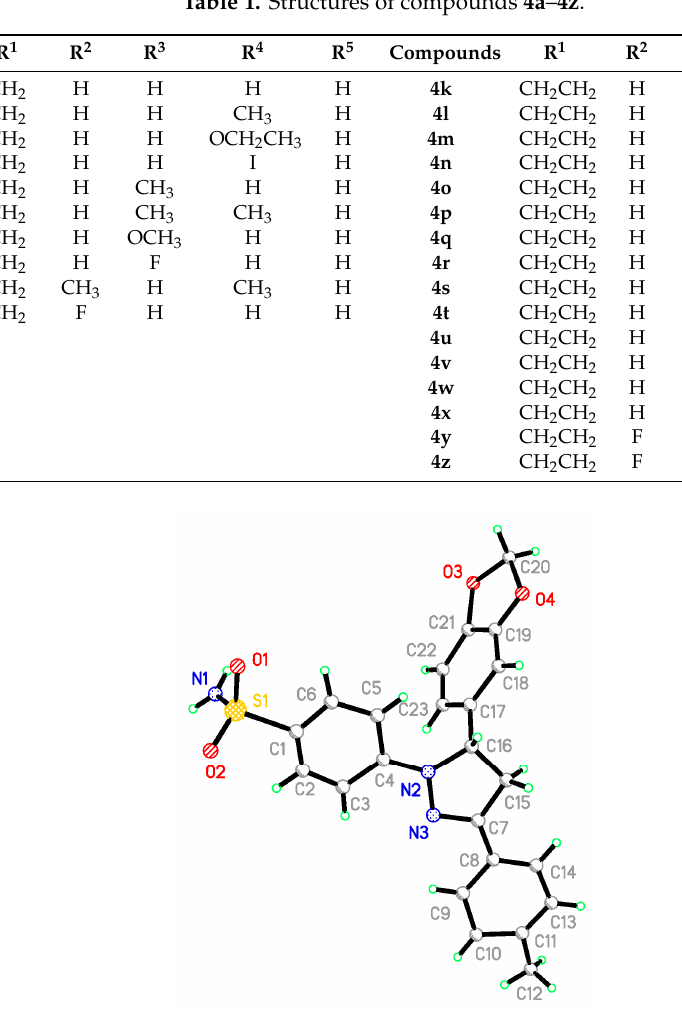
Figure 2. Crystal structure diagrams of compound 4b . Table 2. Crystal data for compound 4b .